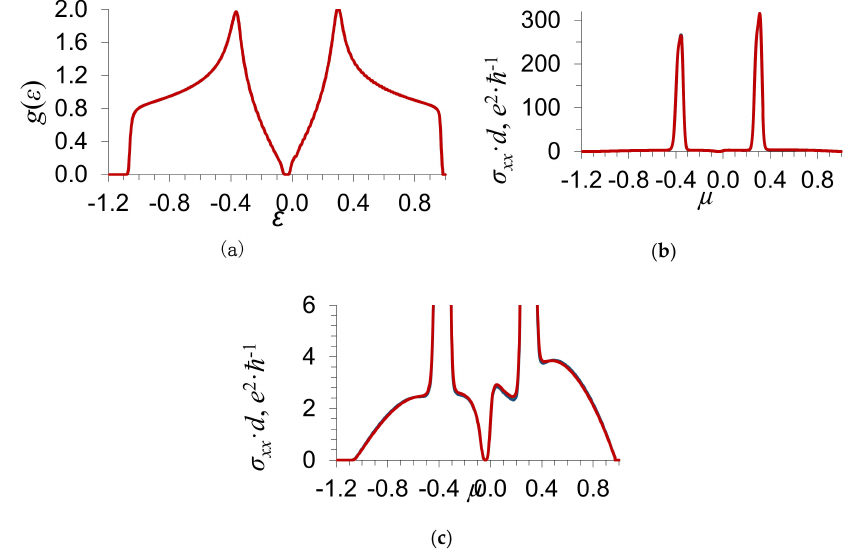
Figure 2. Dependence of ( a ) the density of electron states g ( ε ) on the energy ε ; ( b ) the electrical conductance σ xx ( µ ) on the Fermi level µ , where d is the thickness of a graphene layer; and ( c ) the electrical conductance σ xx ( µ ) on the Fermi level µ (shown on a larger scale). The substitutional impurity concentration y = 0.2, the scattering potential δ / w = − 0.2, the order parameter η = 0.3, and the parameter of binary interatomic correlations ε BB = 0 . The blue curve shows the results of calculations in the approximation of coherent potential, while the red curve shows those with regard to the processes of the scattering of electrons on the pairs of atoms of the first coordinate